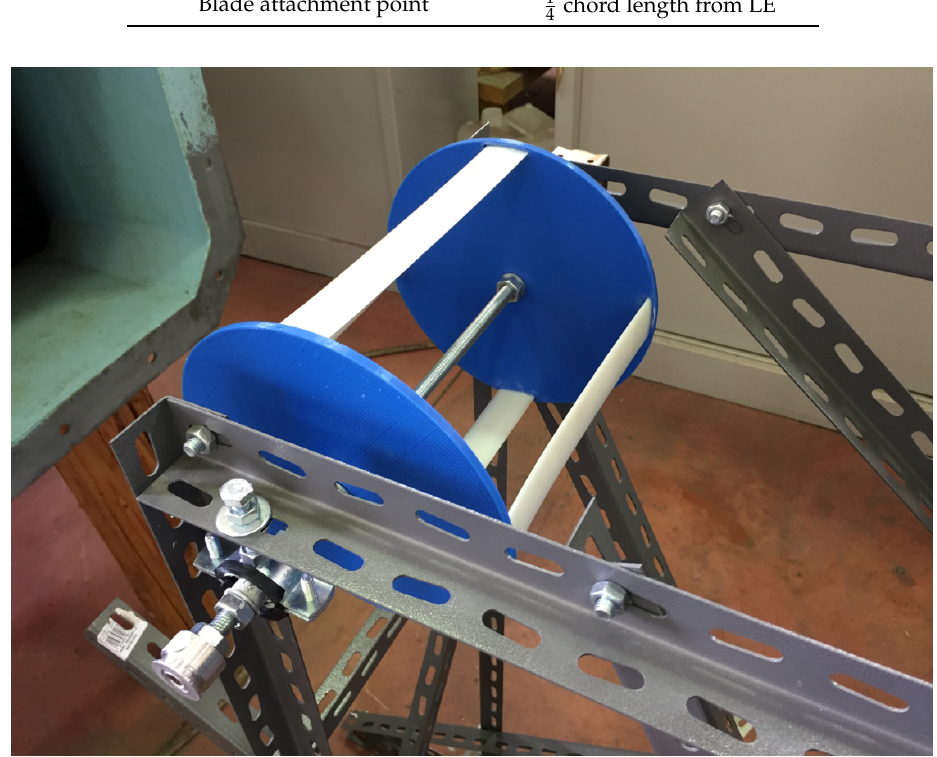
Figure 1. Experimental rotor.